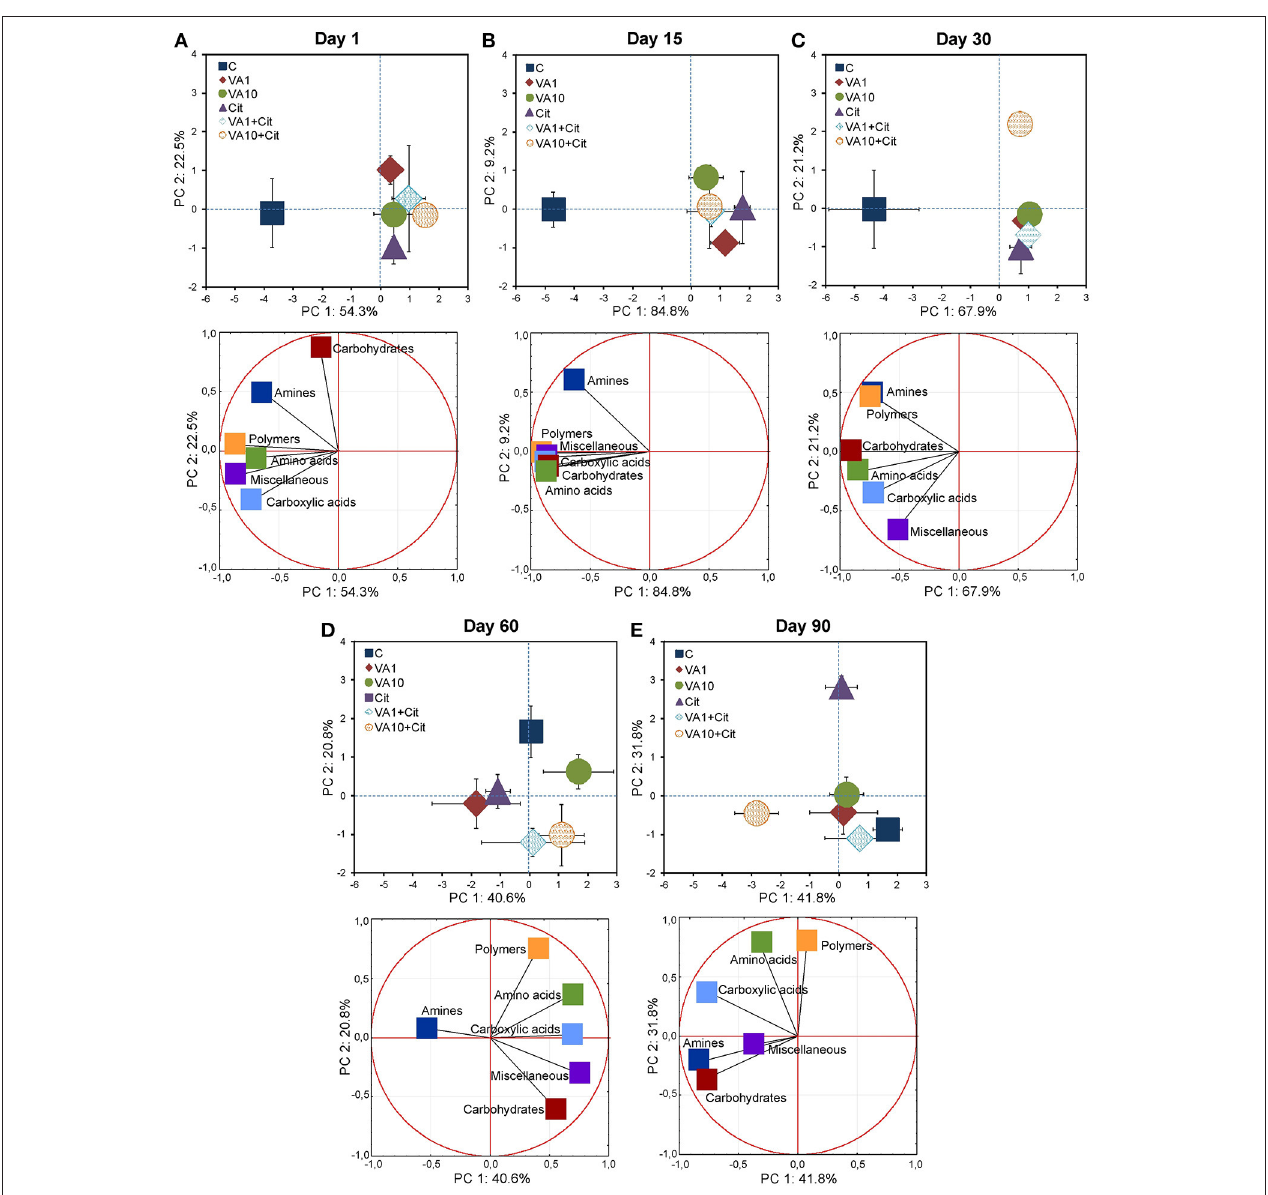
FIGURE 4 | Results of the PCA analysis based on the data of the carbon substrate groups on days 1 (A) , 15 (B) , 30 (C) , 60 (D) , and 90 (E) . The explanation of the treatment abbreviations is given in Figure 1 .